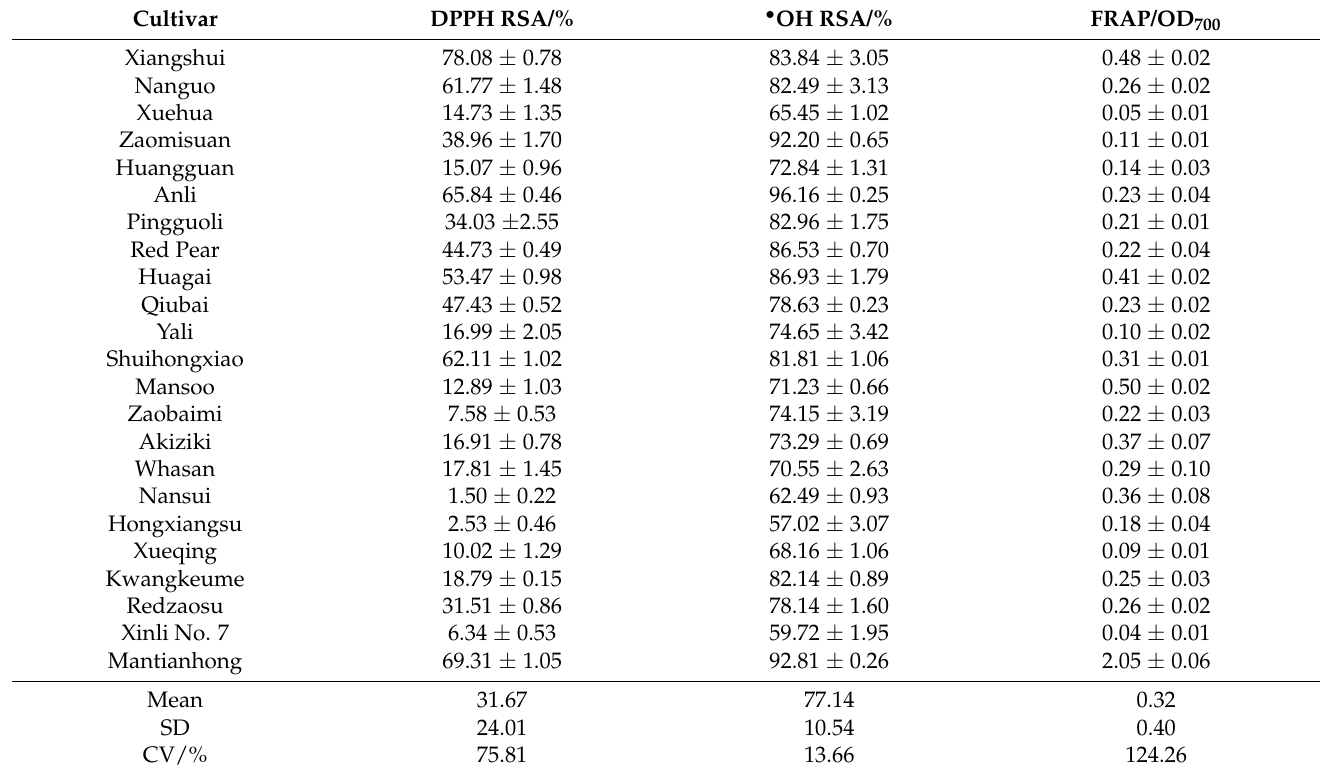
Table 4. Antioxidant activities of pear pastes from 23